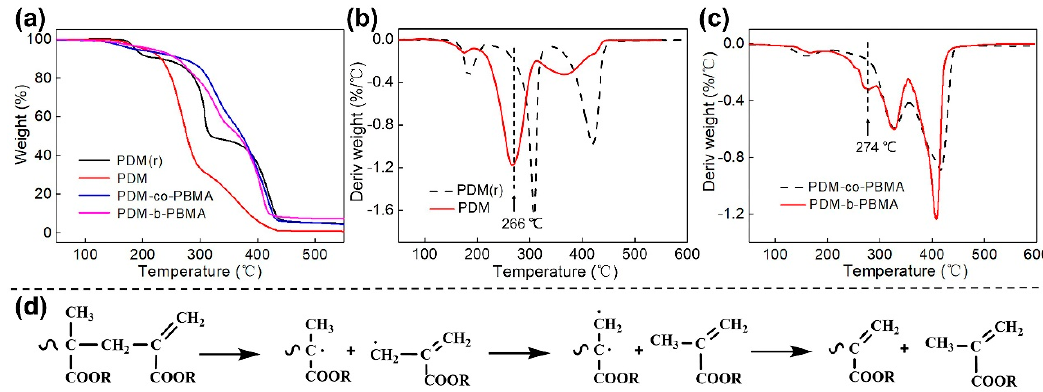
Figure 5. Thermogravimetric (TG) curves of PDM(r), PDM, PDM- co -PBMA and PDM- b -PBMA ( a ), derivative thermogravimetry (DTG) curves of PDM(r) and PDM ( b ), DTG curves of PDM- co -PBMA and PDM- b -PBMA ( c ), decomposition mechanism of PDM- b -PBMA with terminal double bond ( d ).